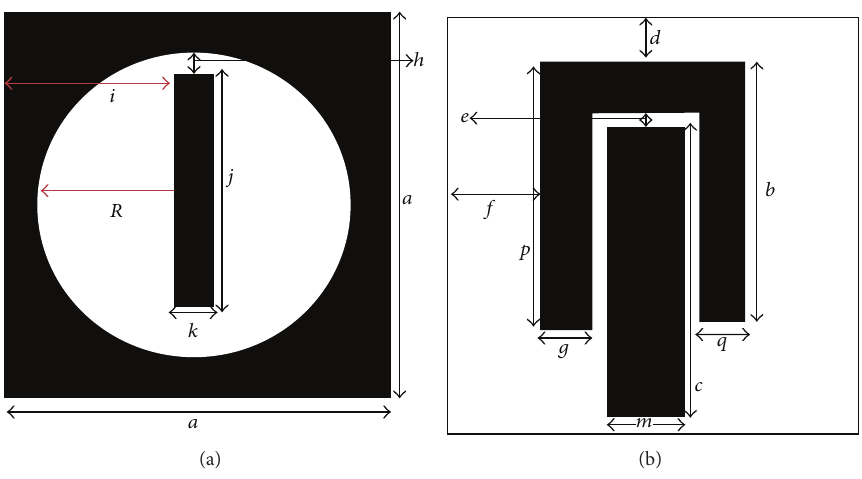
Figure 1: (a) Patch and (b) ground plane of the proposed resonator.